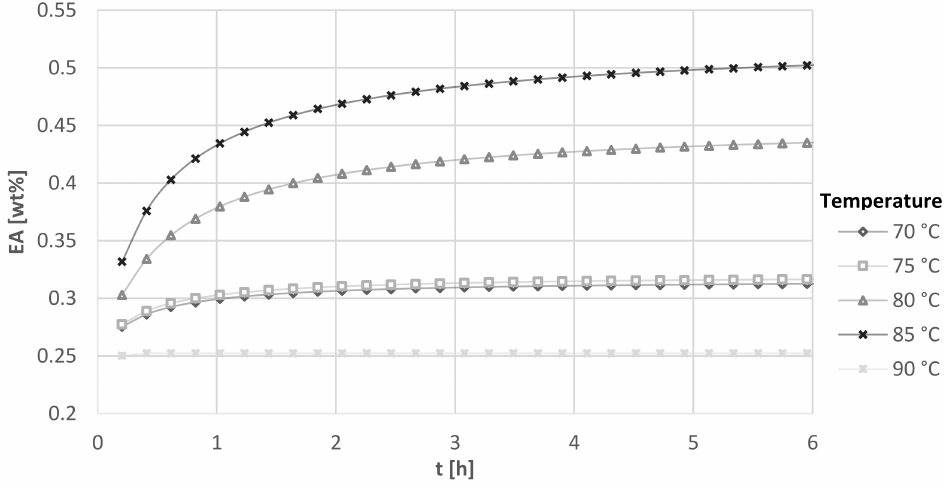
Figure 2. Influence of temperature and residence time on the conversion in the